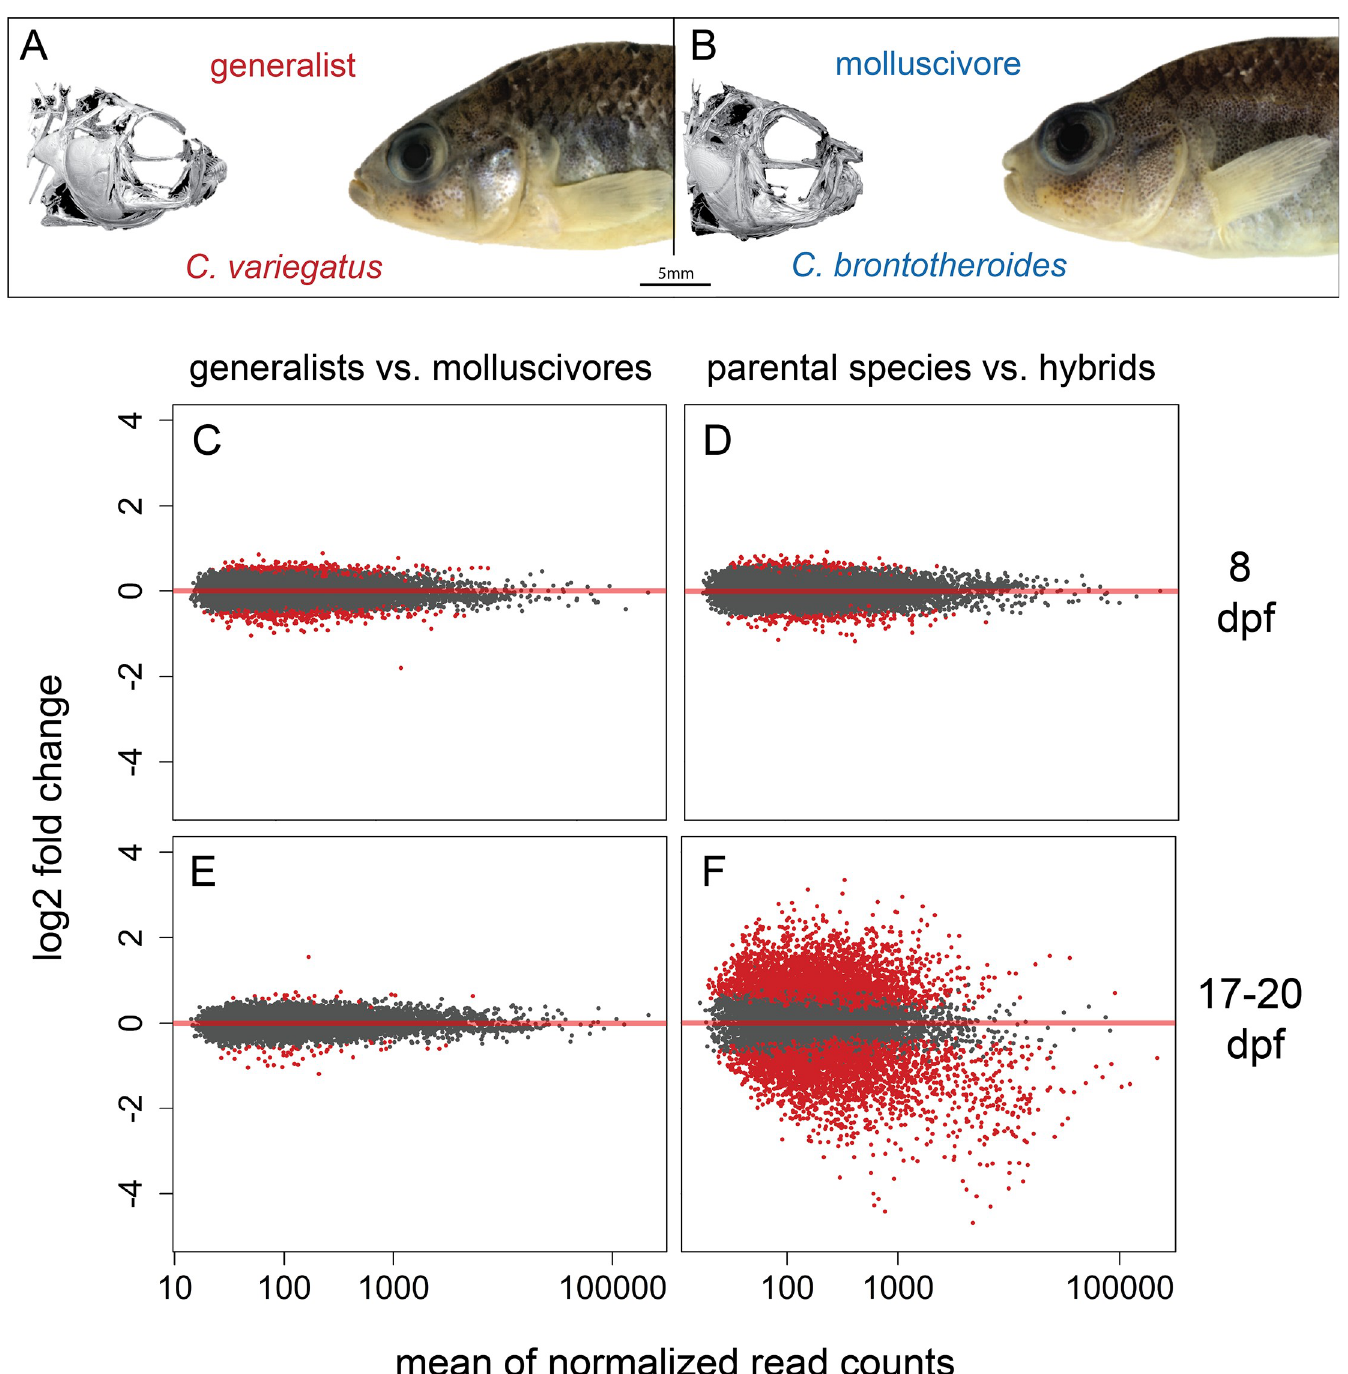
Fig 1. Extensive misregulation in F1 hybrid craniofacial tissues. (A) Cyprinodon variegatus –the generalist. (B) C . brontotheroides– the molluscivore ( μ CT scans of the cranial skeleton of each species modified from [66]. Variation in gene expression (C) between generalists vs. molluscivores 8 days post fertilization (dpf), (D) parental species vs. hybrids at 8 dpf, (E) generalists vs. molluscivores at 17–20 dpf, and (F) parental species vs. hybrids at 17–20 dpf. Red points indicate genes detected as differentially expressed at 5% false discovery rate with Benjamini-Hochberg multiple testing adjustment. Grey points indicate genes showing no significant difference in expression between groups. Red line indicates a log2 fold change of zero between groups. Points above/below the line are upregulated/downregulated in molluscivores relative to generalists (C and E) or hybrids relative to parental species (D and F).